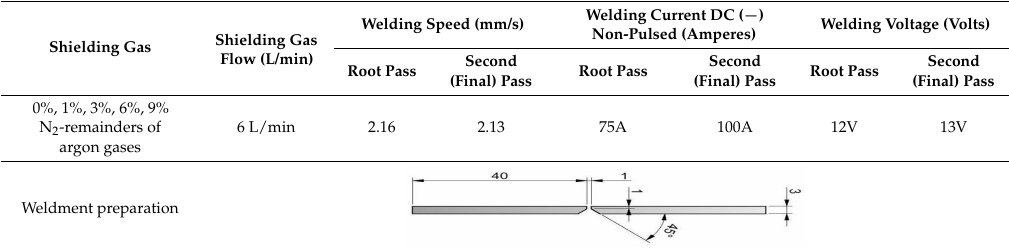
Table 3. Welding